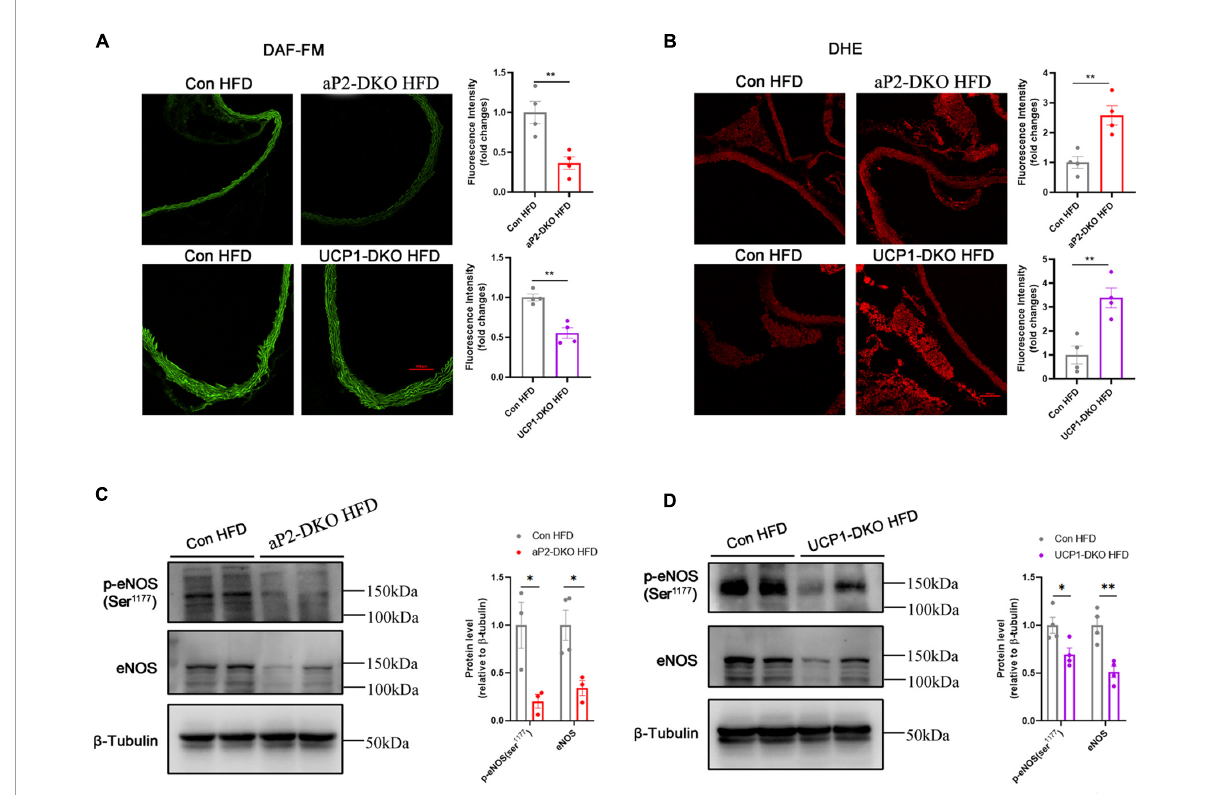
FIGURE4 Deficiency of bone morphogenetic protein 4 (BMP4) in perivascular adipose tissue (PVAT) inhibits Nitric oxide (NO) release and induces reactive oxygen species (ROS) production. Aortic tissues were collected from the control, aP2-DKO and UCP1-DKO mice with 12-week HFD. (A) Representative fluorography for DAF-FM DA staining (left) and Quantification of DAF-FM DA fluorescent intensity (right) ( n = 4). (B) Representative fluorography for DHE staining (left) and Quantification of DHE fluorescent intensity (right) ( n = 4). (C) Western blot analysis (left) and quantification (right) of eNOS phosphorylation and total eNOS levels in aortae from the control and aP2-DKO mice. (D) Western blot analysis (left) and quantification (right) of eNOS phosphorylation and total eNOS levels in aortae from the control and UCP1-DKO mice. Values are means ± S.E.M. * P < 0.05, ** P < 0.01, and *** P < 0.001 by unpaired Student’s t-test (A–D)